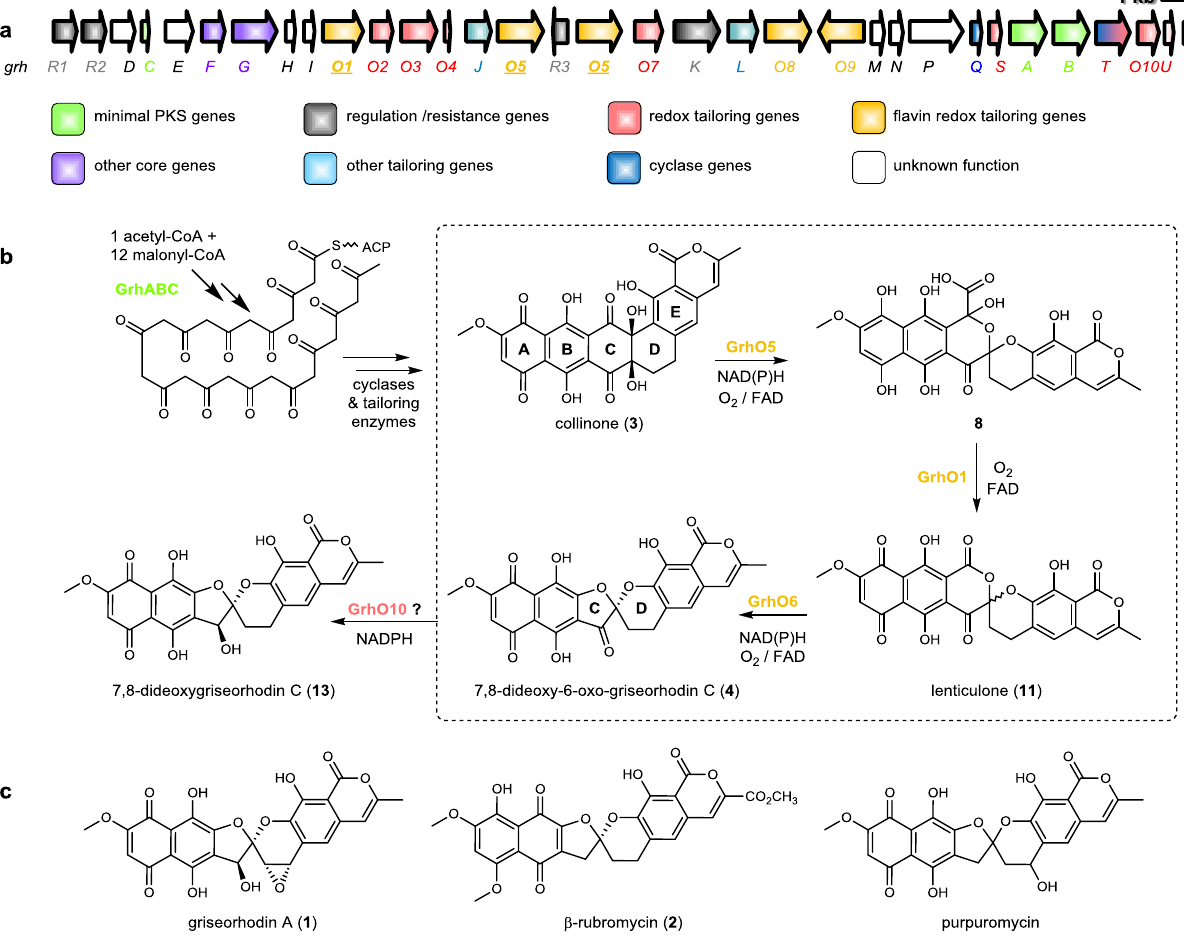
Fig. 1 Overview of the proposed biosynthesis of bacterial rubromycin-type polyketides and fi nal pathway products. a Griseorhodin A biosynthetic gene cluster encoding, e.g., the minimal type II polyketide synthase (PKS), cyclases, and tailoring enzymes 9 . b Initial steps afford a reactive acyl-carrier protein (ACP)-bound poly- β -ketone, which is subsequently cyclized and modi fi ed to 3 . Compounds 3 and 11 were previously identi fi ed in the course of gene deletion experiments ( Δ grhO5 and Δ grhO6, respectively, encoding fl avin-dependent tailoring enzymes investigated in this work) and assigned as putative advanced intermediates 10 . The conversion of 3 into 4 via 8 and 11 (dashed box) and additional intermediates was elucidated in this work. A ketoreductase (presumably GrhO10) then converts 4 into 13 . c Examples of mature rubromycins likely formed from 13